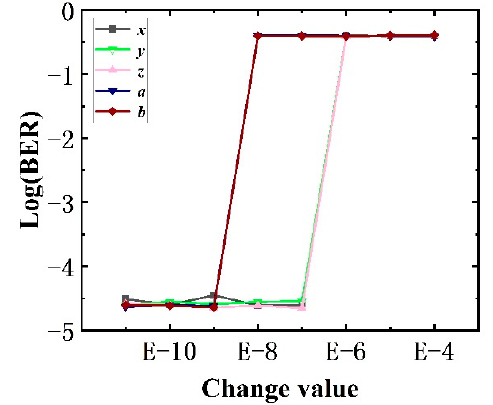
Figure 12. The curves of BER with a tiny change in the initial value.